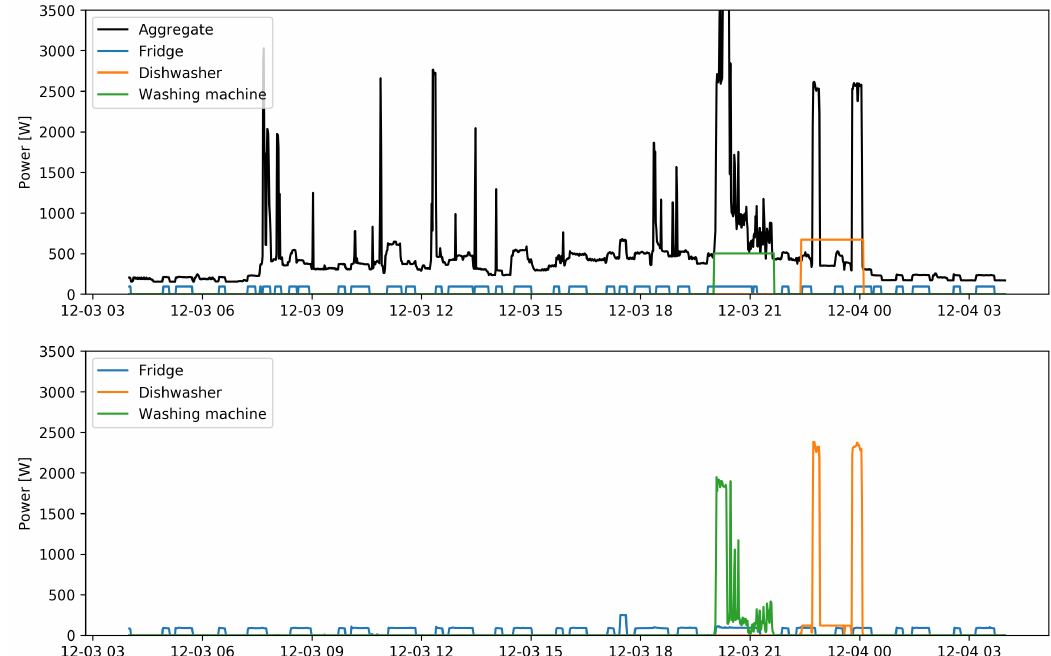
Figure 2. Example of load disaggregation for the seen case. The upper graph shows the aggregate load and the estimated consumption obtained by the method, while the lower graph shows true values of the power absorbed by the three appliances. The estimated value of the consumption of household appliances in the upper part of the figure is assumed to be constant for the activation periods and equal to the average consumption during use.